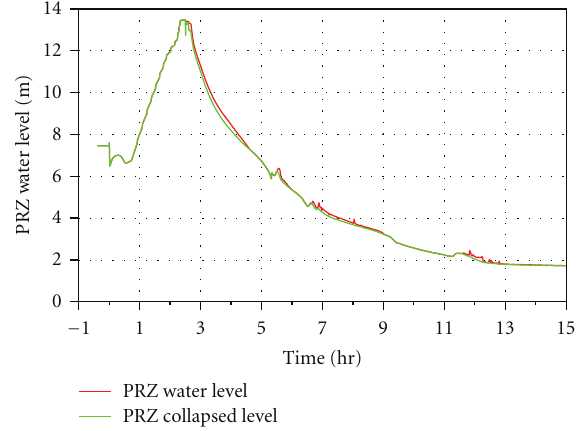
Figure 20: Temperature of fuel and coolant channels in R1 to R6 of upper core.